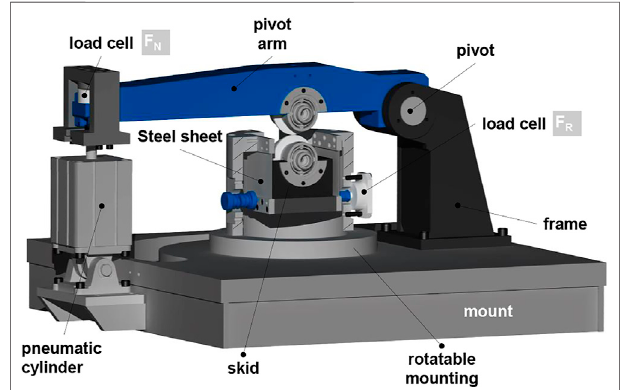
FIGURE 2 | Mechanical layout of the considered FZG twin-disk tribometer (Ebner et al., 2018a).